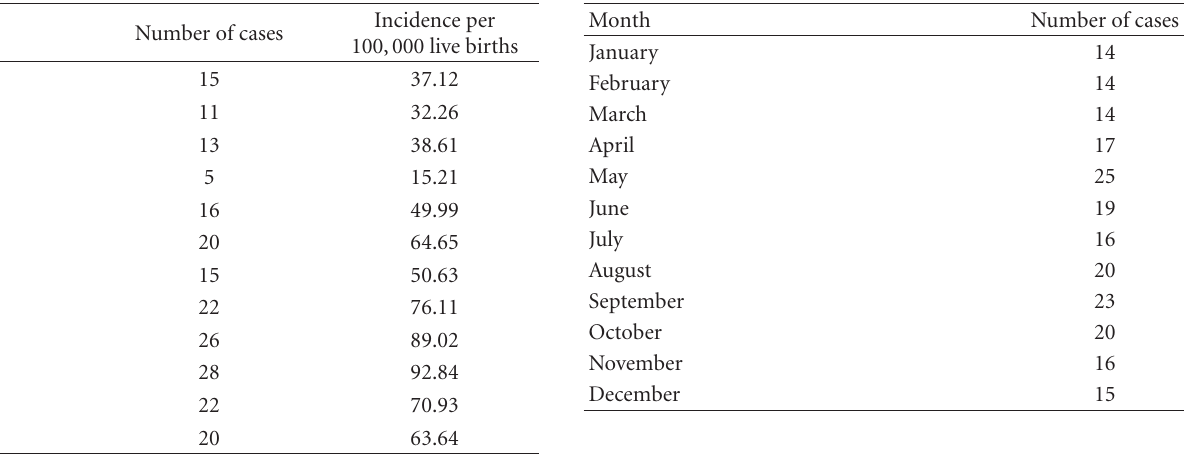
Table 2: Annual number of cases and incidence of elevated TSH levels on newborn screening in the Northern Region of England,